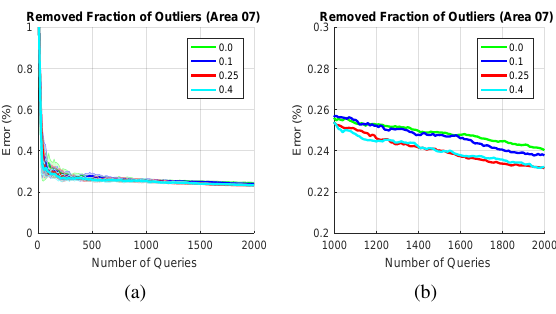
Figure 2. Reproduction of the results from (Munoz-Mari et al., Figure 4. Results of extending active queries with the proposed 2012) for the Brutisellen dataset (a). The result is the same as local segmentation for area 7 (a) and 30 (b) of the Vaihingen originally reported, though the final classification error was 12% dataset. The red learning curves (“Pixel”) are achieved by in our case instead of 8%. The active strategies s1 and s2 clearly applying the original active query method directly on the pixels outperform the random sampling strategy s0. Applied to area 7 of the image. The blue curves (“SLIC”) are achieved when the of the Vaihingen dataset, the results are not as distinct, but active proposed extension is used with the SLIC algorithm. The dashed learning is still better (b). lines are the results of removing mixed pixels from the border regions beforehand.